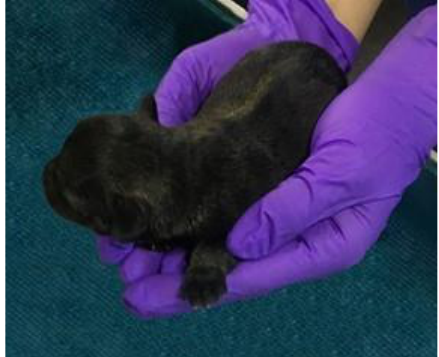
Figure 2. Held treatment — the puppy was held in a sternal